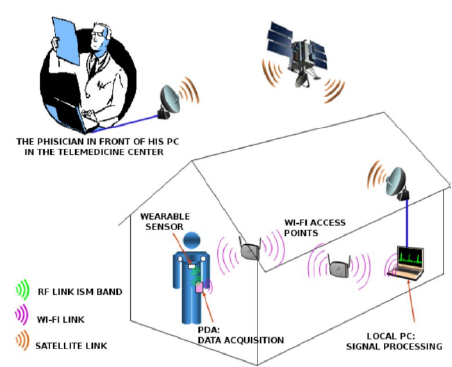
Figure 1. Global scheme of ECG monitoring in OURSES project